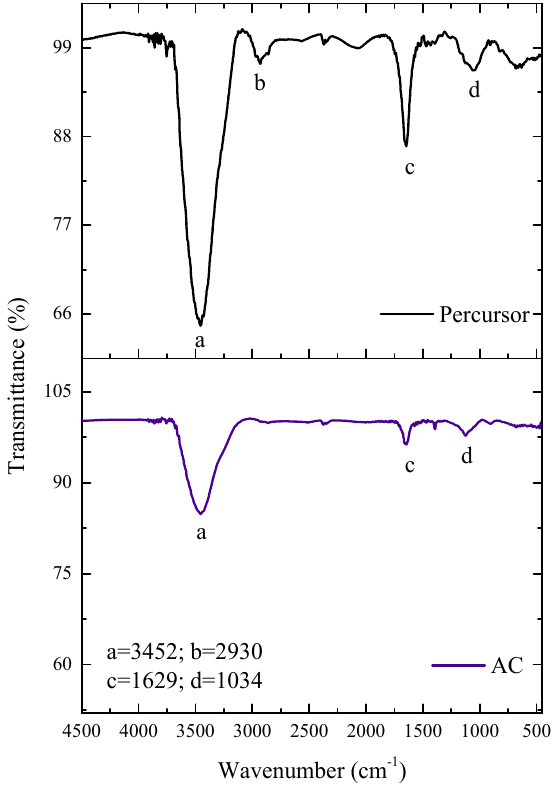
Figure 3. FT–IR spectra of precursor and AC materials.